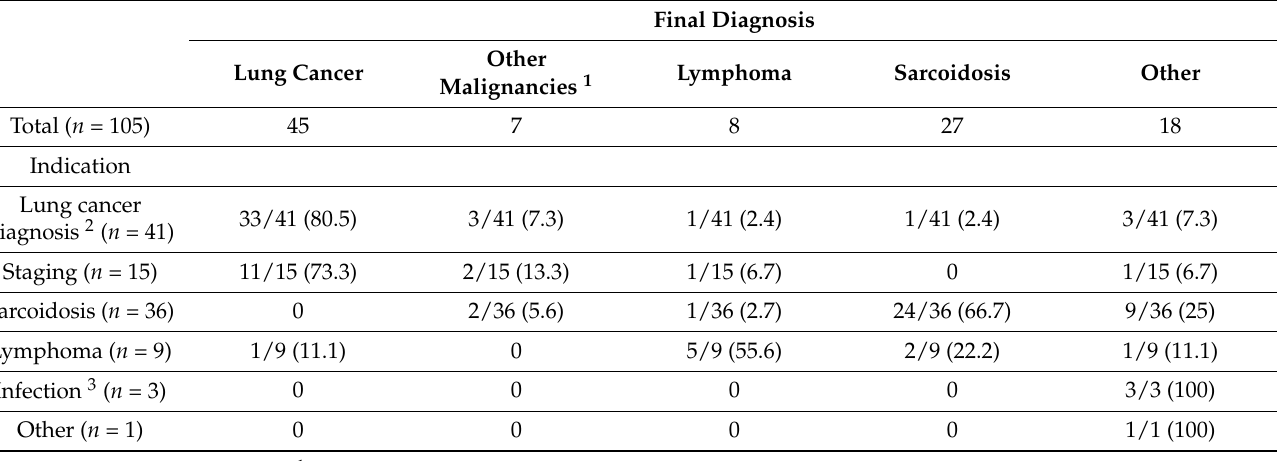
Table 3. Indications for EBUS-TBFB and the final